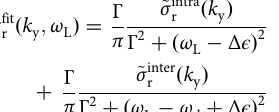
≈ ω 0 d /2. The dashed lines indicate the Floquet